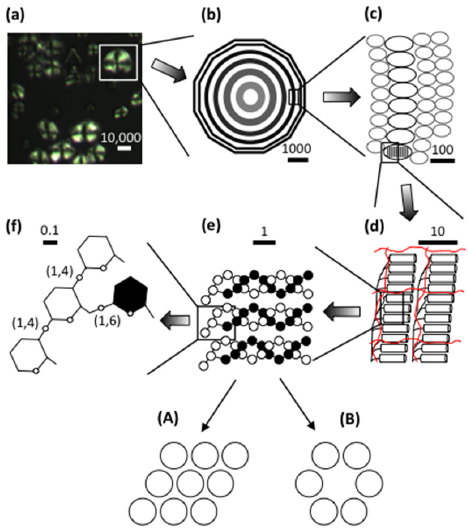
Figure 1. Dimensions in starch: from granules to glucosyl units. ( a ) Maize starch granules observed under polarised light showing the “Maltese cross”, which is indicative of a radial organisation within the starch granule. ( b ) A hypothetical granule (in this case polyhedral) with growth rings extending from the hilum. ( c ) Blocklets in semi ‐ crystalline (black) and amorphous (grey) rings. ( d ) Crystalline and amorphous lamellae formed by double helices (cylinders) and branched segments of amylopectin (black lines), respectively. Amylose molecules (red lines) are interspersed among the amylopectin molecules. ( e ) Three double ‐ helices of amylopectin. Each double ‐ helix consists of two polyglucosyl chains, in which the glucosyl residues are symbolised by white and black circles, respectively. The double helices form either A ‐ or B ‐ polymorphic crystals (A and B, respectively, in which the circles symbolises the double helices seen from the edge). ( f ) Glucosyl units showing α‐ (1,4) ‐ and α‐ (1,6) ‐ linkages at the base of the double ‐ helix. The bar scale (in nm) is only approximate to give an impression of the size dimensions.